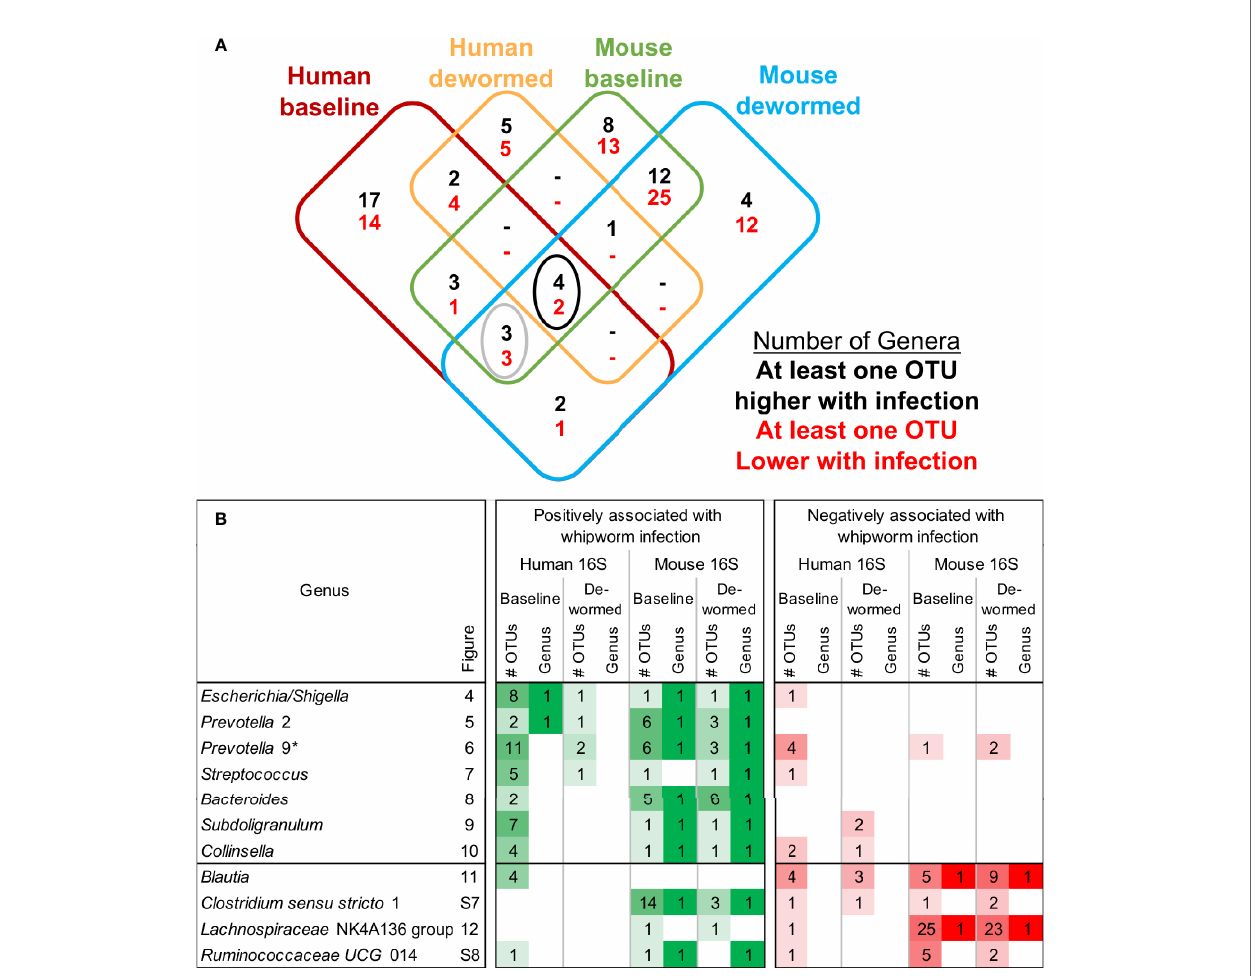
FIGURE 3 | Overview of differential taxa abundance results. (A) Venn diagram of differentially abundant genera counts across each comparison (corresponding to each of the uninfected vs infected comparisons outlined in Figure 1A ), requiring at least one OTU belonging to the genera to be sign fi cantly differentially abundant. Black circle = differentially abundant genera in each of the four comparisons, gray circle = differentially abundant genera in the human baseline, mouse baseline, and mouse dewormed comparisons, but not in the human dewormed comparison. (B) Genera from the circled regions of panel (A) , indicating the genera name, the corresponding fi gure number displaying full OTU abundance data, the number of OTUs signi fi cantly associated with whipworm infection, and whether the entire genus was signi fi cantly associated with infection. Lighter and darker shades of green and red are used to indicate lower/higher signi fi cant OTU counts (respectively) for each genus. * Prevotella 9 was also one of the three genera downregulated in three comparisons (human baseline, mouse baseline and mouse dewormed comparisons, but not in the human dewormed